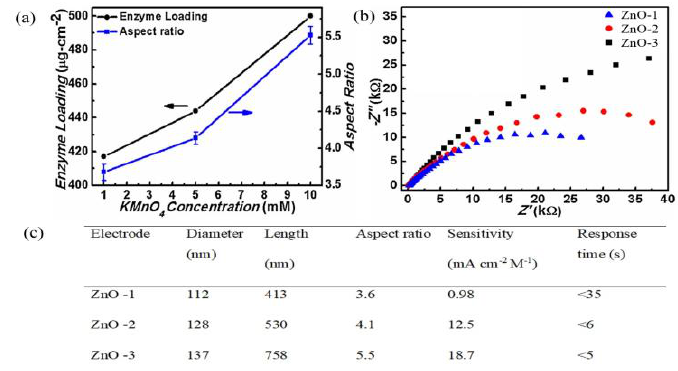
Figure 8. ( a ) Enzyme loading per unit area of electrode (left Y-axis) and aspect ratio variation (Right Y-axis) with variation in KMnO 4 (mM). ( b ) The Nyquist plot of di ff erent electrodes. ( c ) Comparison of aspect ratio and sensor performance of di ff erent types of electrodes with average length and diameter distribution. Reprinted from [96]. Copyright 2017, with permission from Elsevier.